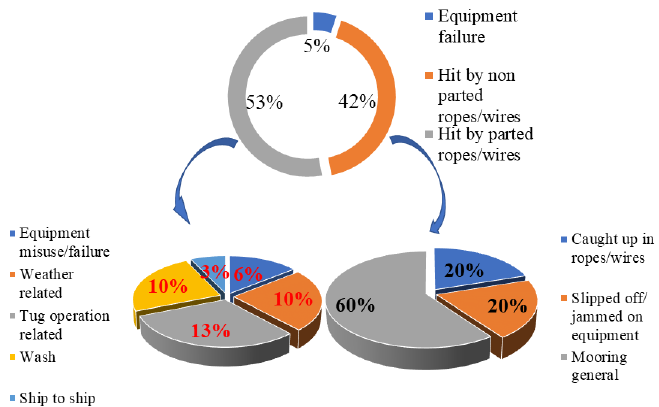
Figure 1. Types of incidents resulting in personal injury from 1995 to 2016 (adapted with permission from Ref. [19]. Copyright 2020 Cayman Registry).